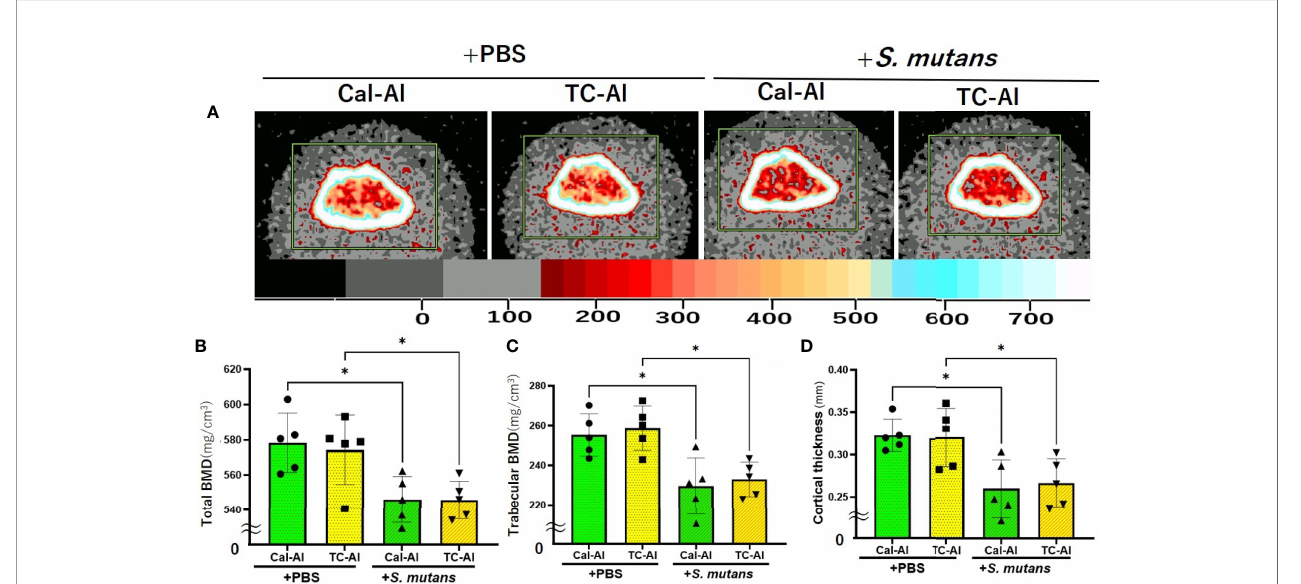
FIGURE 5 | S. mutans inoculation reduced bone mineral density. Quantitative analyses of the bone mineral content of the diaphysis of distal femurs after seven days of intravenous injection of PBS or S. mutans inoculation. (A) Representative pQCT image of the distal femurs for quantitative analyses. The color palette for bone mineral density is shown in the lower bar. (B) Total bone mineral density (Total density) of the distal femur; (C) Trabecular bone mineral density (Trabecular density) of the distal femur; (D) Cortical bone thickness (Cortical thickness) of the distal femur. Cal-Al, mice received double injections of calcein and alizarin; TC-Al, mice received double injections of tetracycline and alizarin; +PBS, intravenously PBS-injected groups; +S. mutans , intravenously S. mutans -inoculated groups. The variance of data was analyzed by the Levene test. The comparison between groups was analyzed by the ANOVA and Tukey HSD test. Values are expressed as the mean ± SD, *p < 0.05.